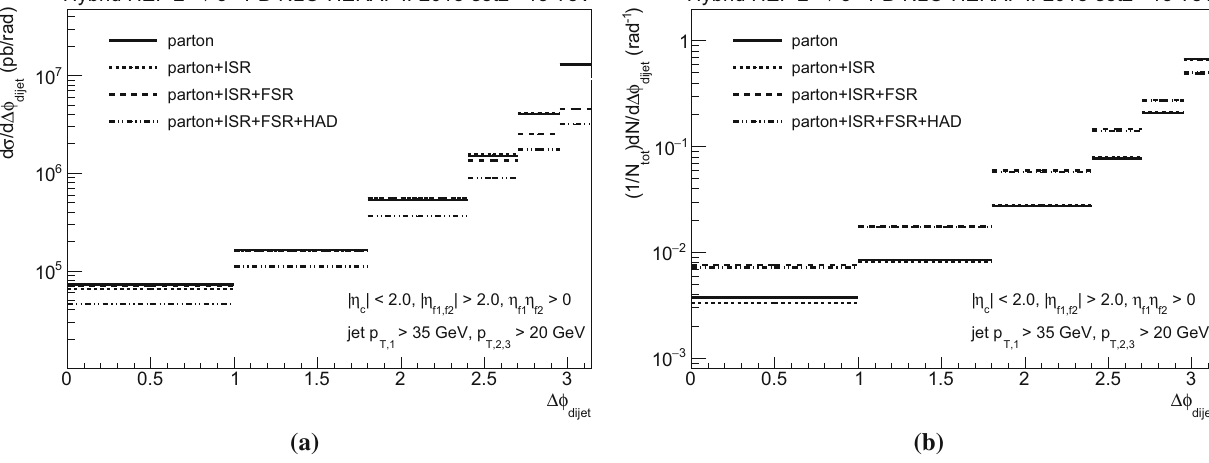
Fig. 4 Hybrid formalism predictions at parton level for 2 → 3 processes with subsequently adding ISR, FSR, and hadronisation. The PB-NLO- HERAI+II-2018-set2 PDF is used for all predictions. Shown in absolute cross sections ( a ) and normalised distributions ( b